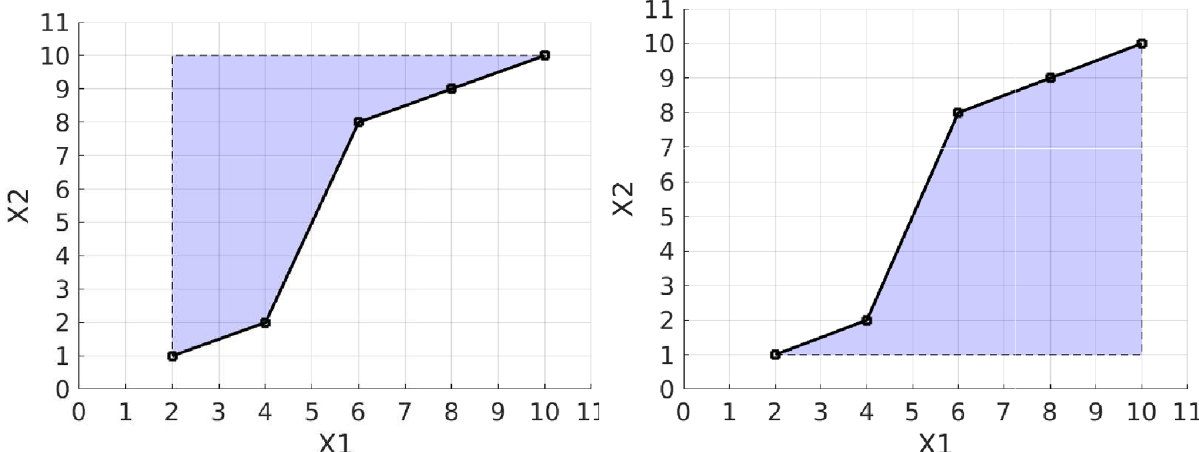
Fig 3. Geometric interpretation of the cross terms in the signature using the same path as in Fig 2. The graph on the left shows the shaded area representing S (1,2) with value 31 and the graph on the right shows S (2,1) where the shaded area has a value of 41. These terms both measure the deviation from a straight line and they distinguish cases where X1 increases quickly relative to X2 and vice versa.